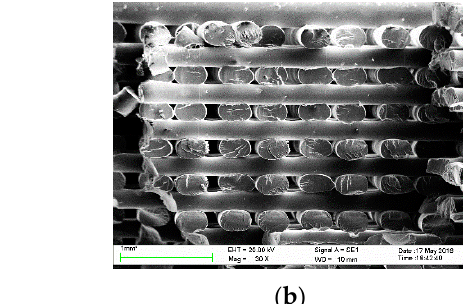
Figure 2. SEM images of FFF parts showing: ( a ) the cross-sectional area of extruded filaments in a two layers array; and ( b ) stacking of several layers.